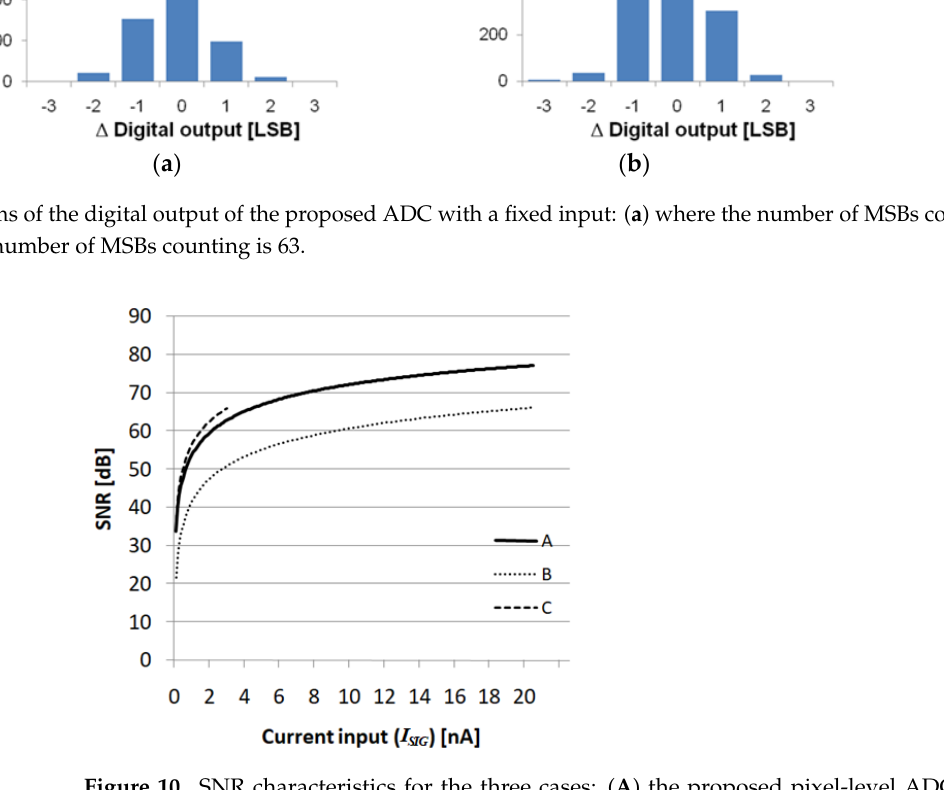
Figure 10. SNR characteristics for the three cases: ( A ) the proposed pixel-level ADC; ( B ) 12-bit SS-ADC with reduced integration time; and ( C ) 12-bit SS-ADC with reduced input range.